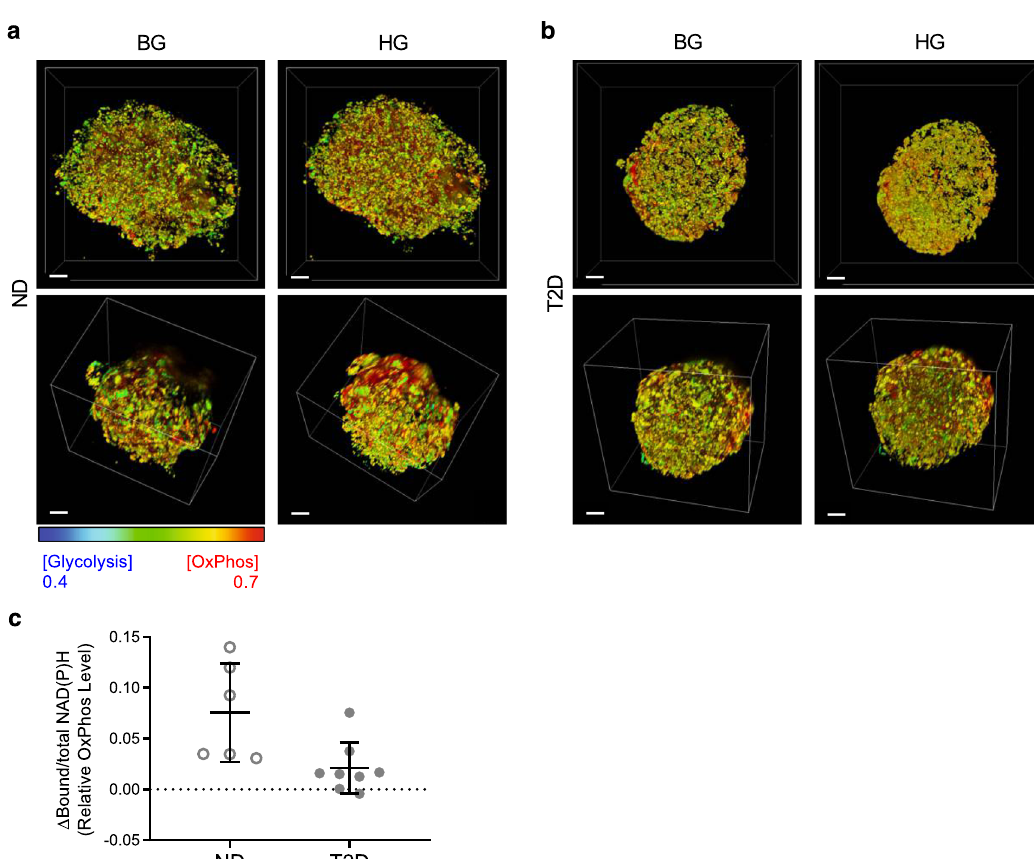
Fig. 5 Human islets. 3D projection of human islets from non-diabetic donors (ND) ( a ) and donors with T2D ( b ) exposed to basal glucose (BG, 4 mM) and high glucose (HG, 16 mM) concentration. c Quanti fi cation of changes in relative OxPhos levels of β cells in ND and T2D human islets presented as mean of each donor sample. n = 8 for T2D (2 donors, 4 islets each), n = 6 for ND (3 donors, 1-3 islets each). Scale bar, 20 µ m. P = 0.1, linear mixed models were used for statistical